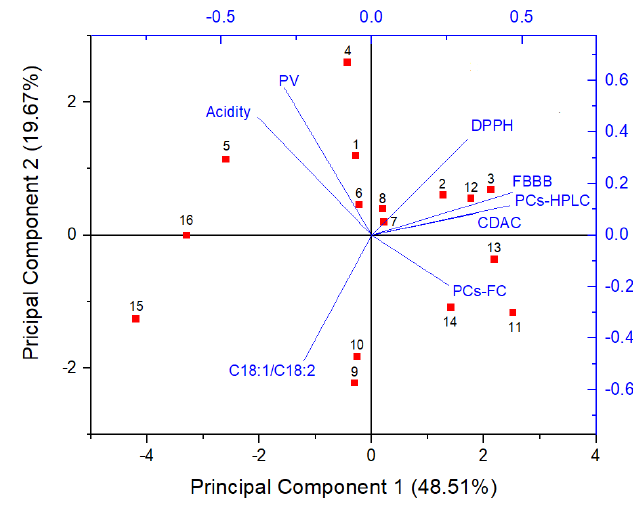
Figure 2. Principal Component Analysis (PCA) biplot for EVOO samples according to the eight sets of values evaluated in this study (acidity, PV, C 18:1 /C 18:2 , PCs-HPLC, PCs-FC, FBBB, CDAC, and DPPH). Samples are numbered as in Table 1.